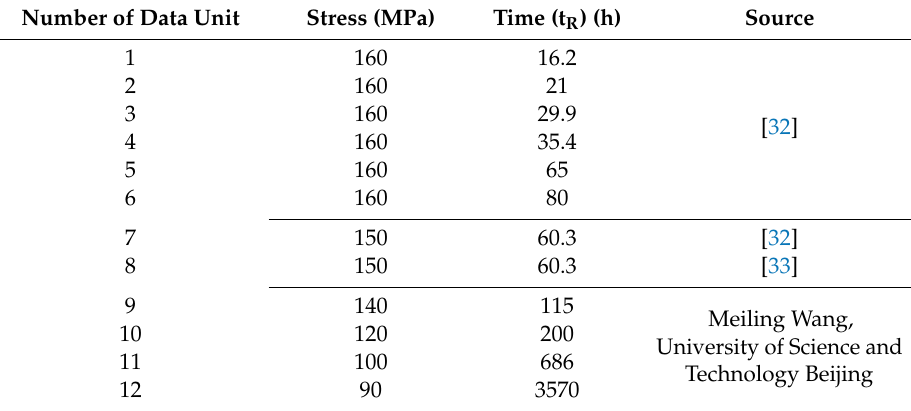
Table 5. Creep-to-rupture data of T91 at 650 ◦